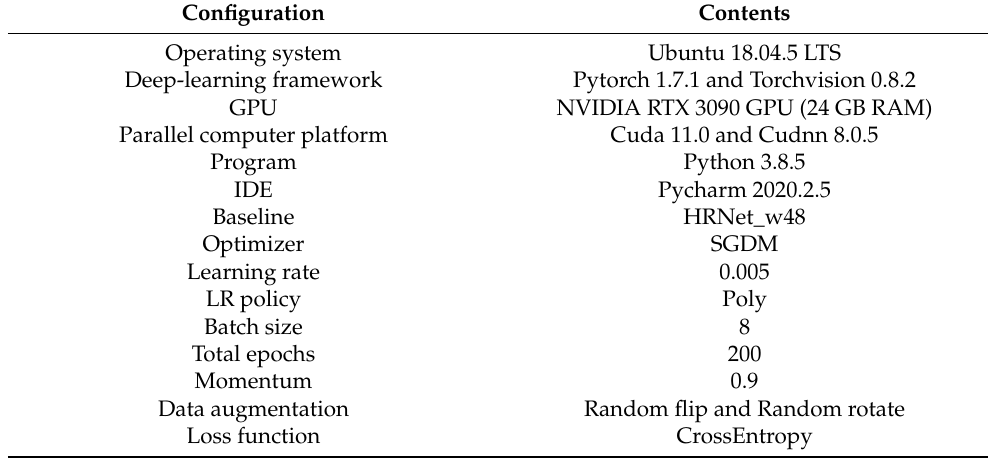
Table 1. Experimental